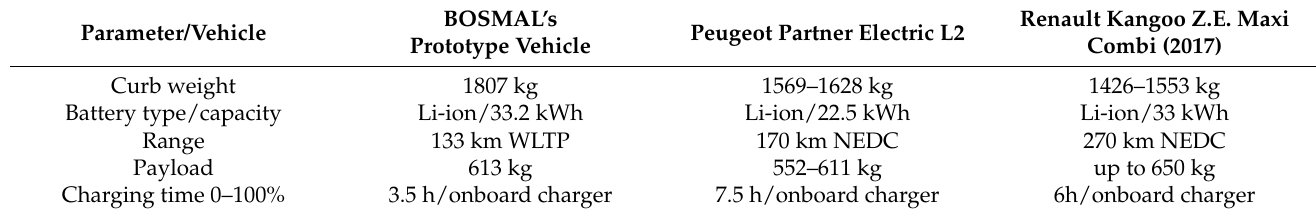
Table 8. BEV benchmark